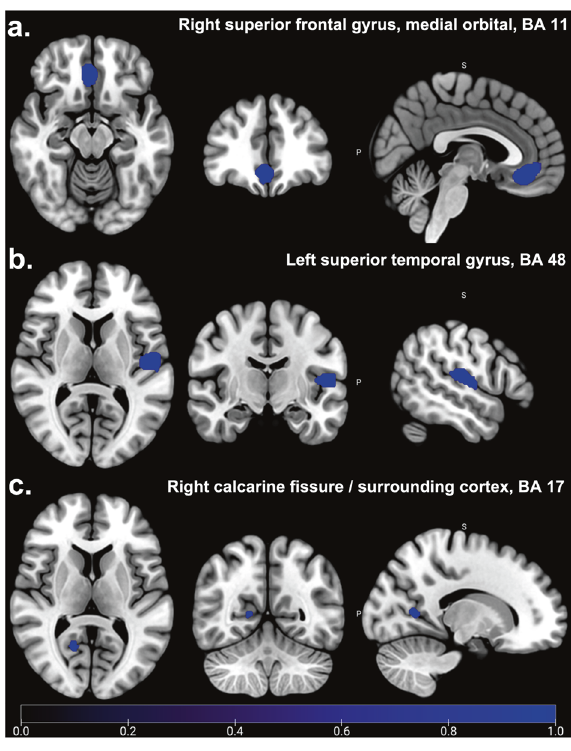
Fig. 2 Signi fi cant GM abnormalities between T2DM-CD and HCs. Patients with T2DM-CD showed signi fi cant and consistent decreased GM (Blue) in right superior frontal gyrus, medial orbital (PFCventmed.R, BA 11) ( a ), left superior temporal gyrus (STG.L, BA 48) ( b ), and right calcarine fi ssure/surrounding cortex (CAL.R, BA 17) ( c ) compared to HCs ( P < 0.005). No increased GM was found in T2DM-CD compared to HCs ( P =